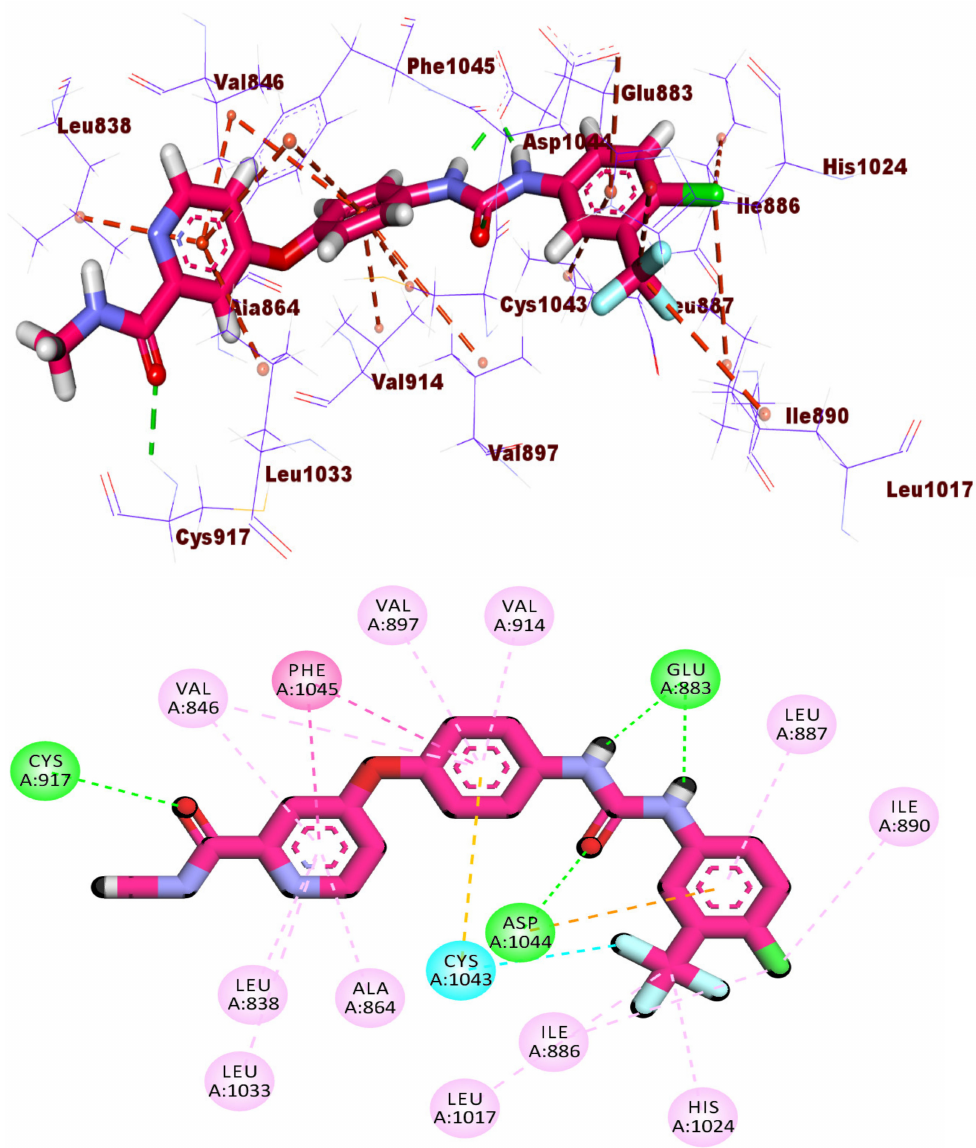
Figure 4. 3D and 2D representation of sorafenib showing its interaction with the VEGFR-2 active